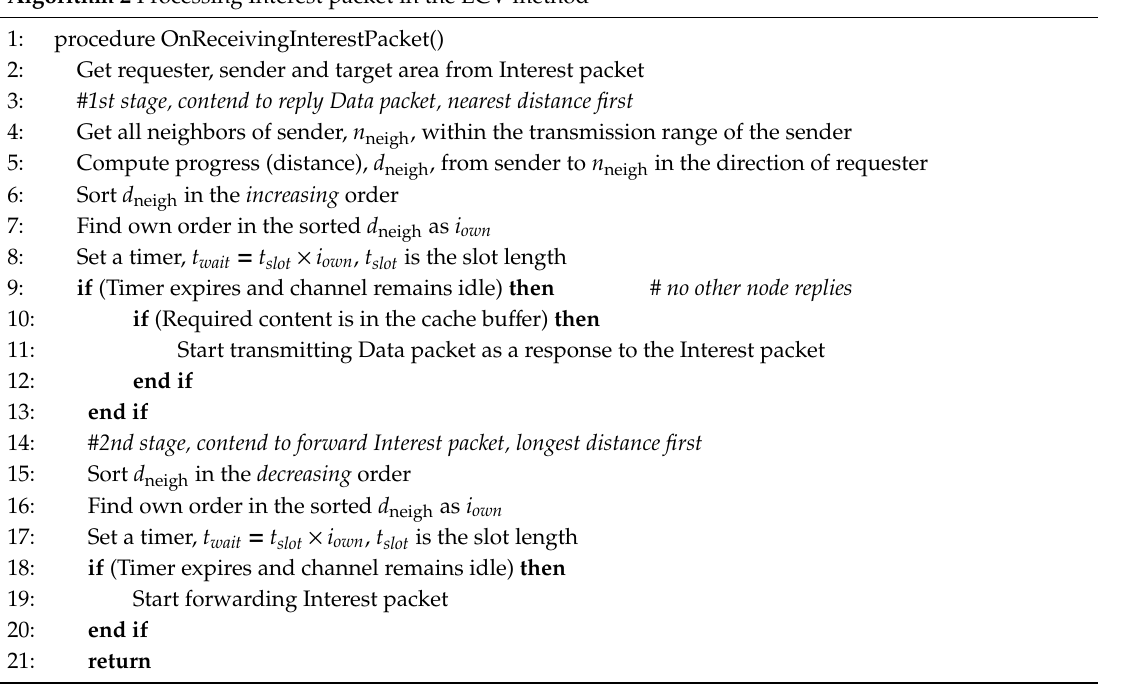
Algorithm 2 Processing Interest packet in the ECV method